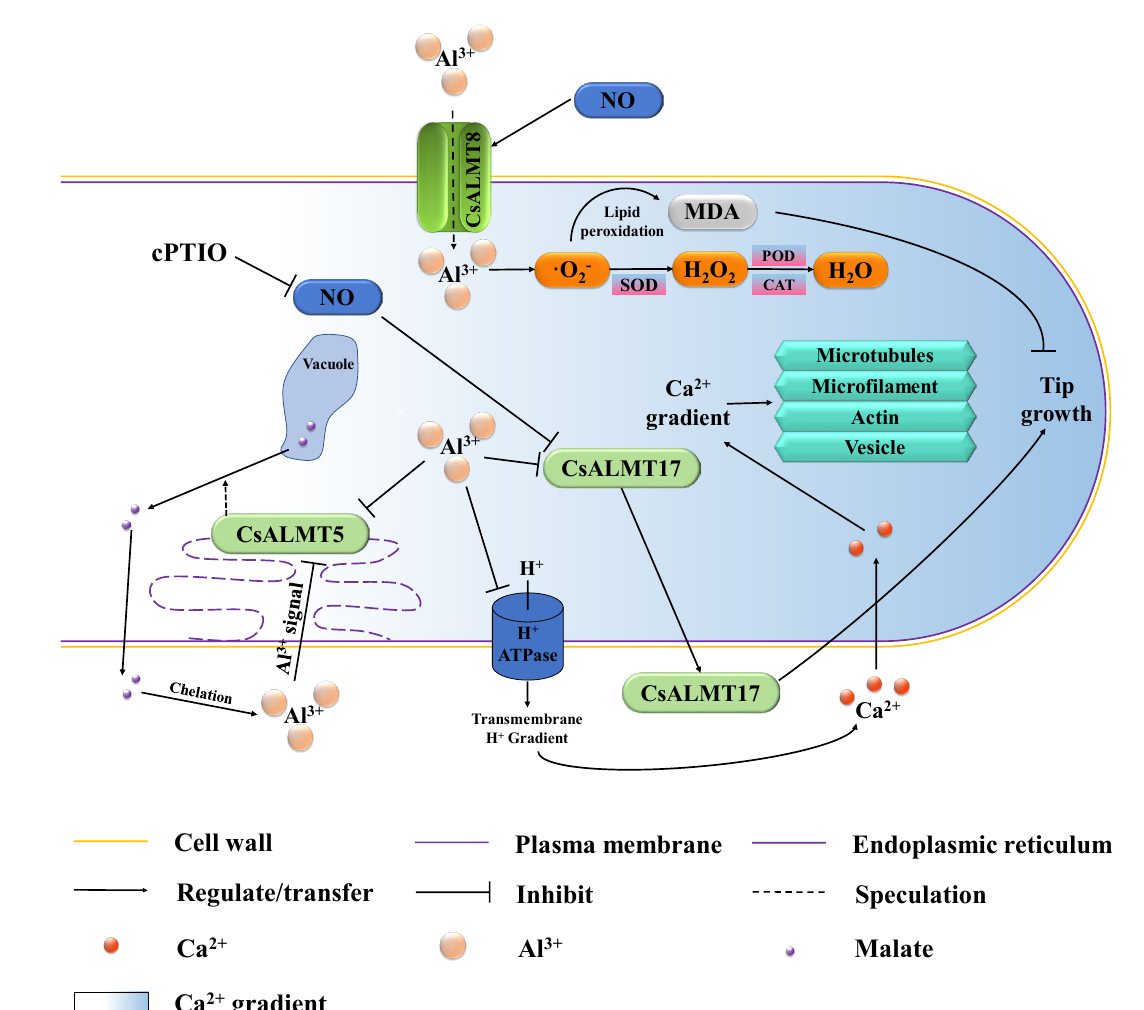
Figure 6. Potential hypothesis model that nitric oxide (NO) participates in exogenous Al 3+ inhibition of C. sinensis pollen tube growth by regulating CsALMTs .